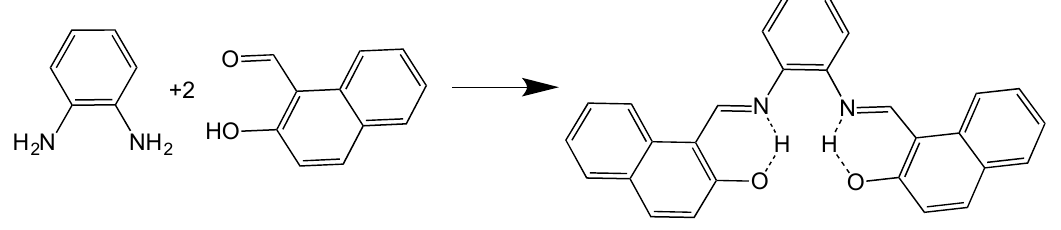
Table 1. Crystal data collection and structural parameters for Syml-Dy2